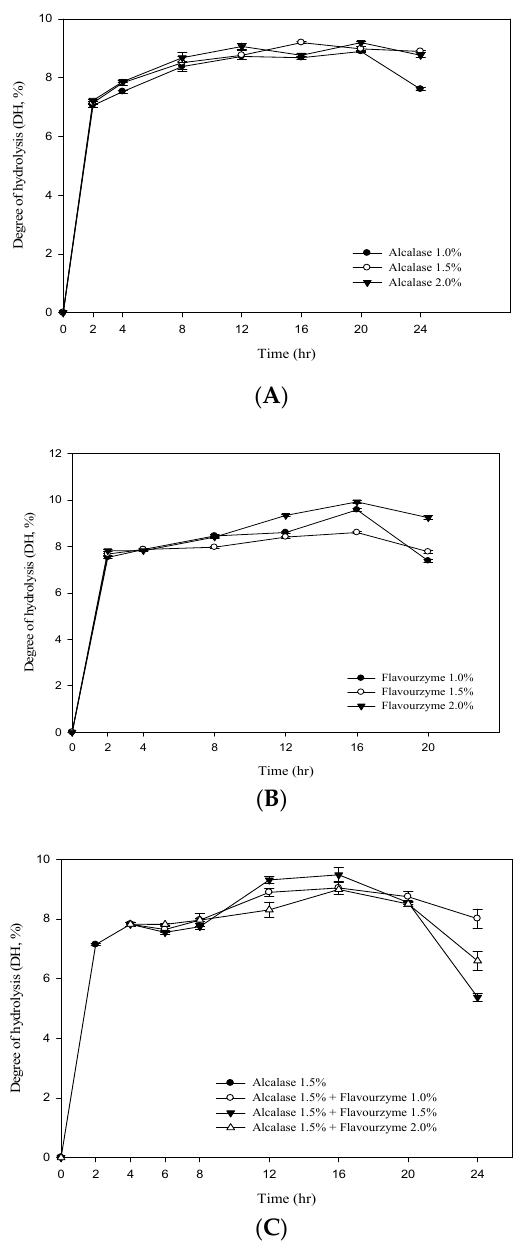
Figure 1. Degree of hydrolysis (DH%) of royal jelly protein hydrolyzed ( A ) by alcalase; ( B ) by flavourzyme and ( C ) during a two-stage hydrolysis using alcalase and flavourzyme.